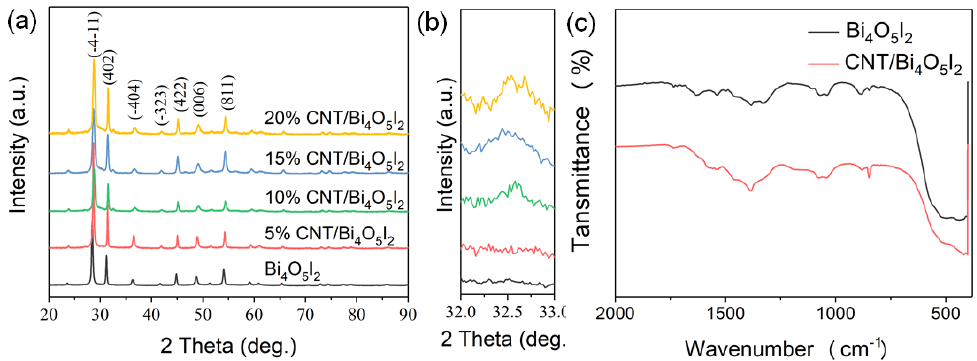
Figure 1. ( a ) XRD patterns, ( b ) the magnification of the region between (402) and (404), and ( c ) FT-IR spectra of the Bi 4 O 5 I 2 and 15% CNT/Bi 4 O 5 I 2 composites.